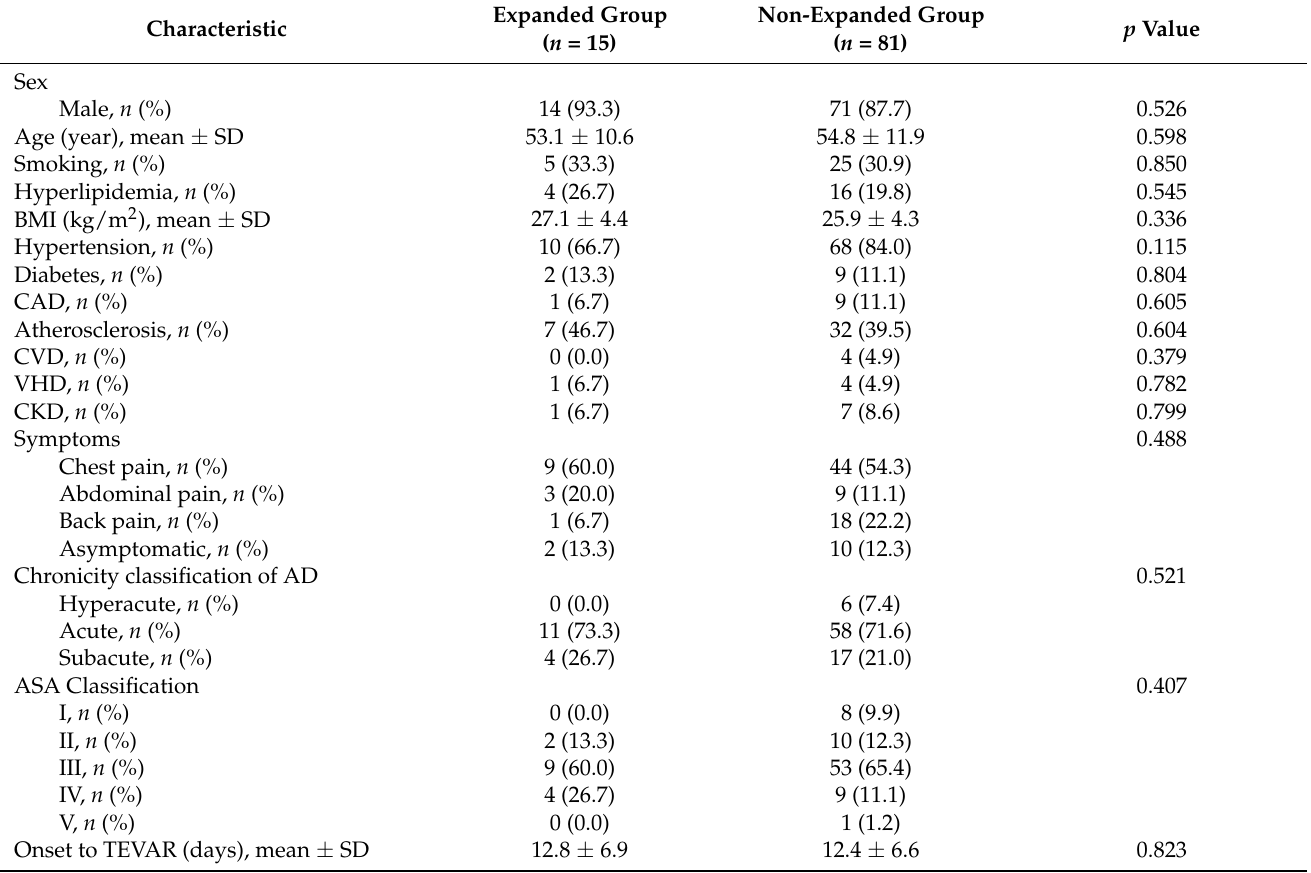
Table 1. Characteristics of 96 patients stratified according to whether late aortic expansion